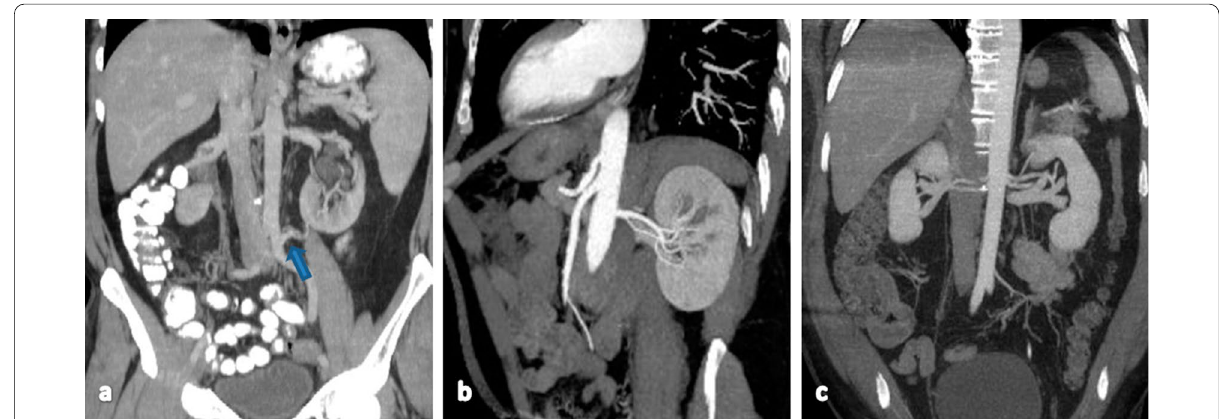
Fig. 2 a Left inferior accessory polar renal artery, originated from left main iliac artery. b Early branching of the left renal artery. c Bilateral accessory hilar renal